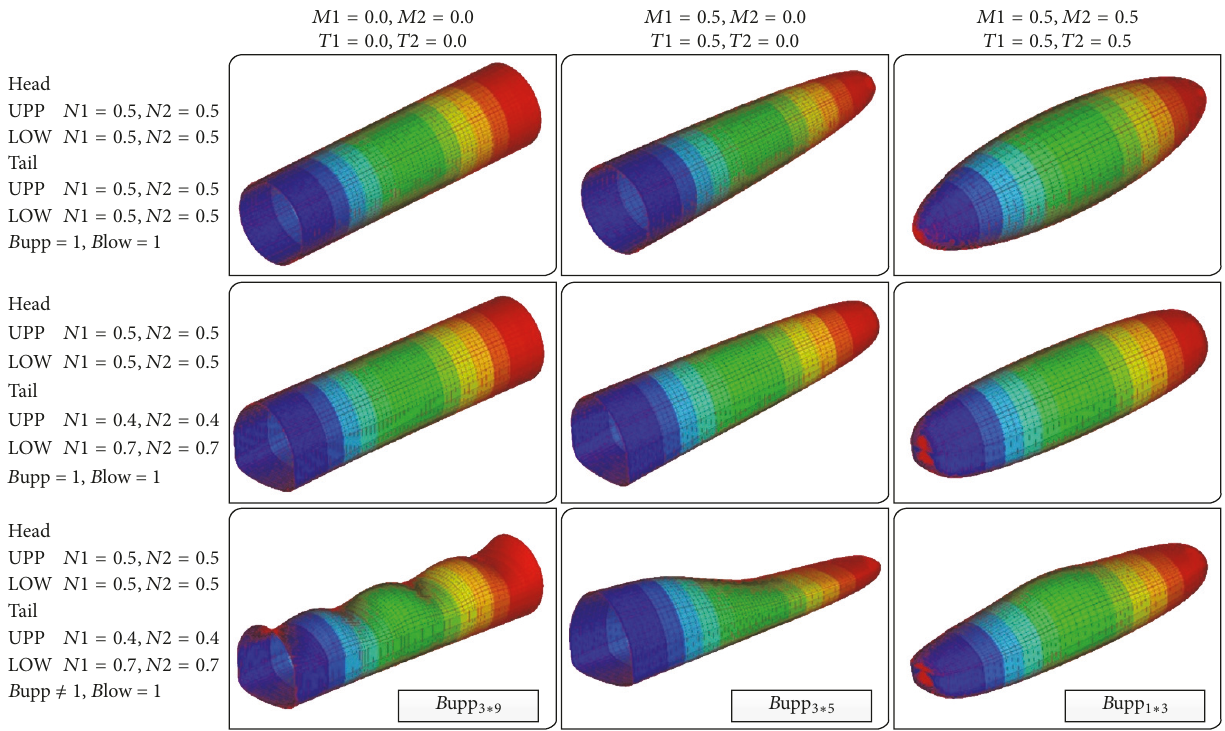
Figure 1: Geometric shapes with different control parameters generated by the three-dimensional CST